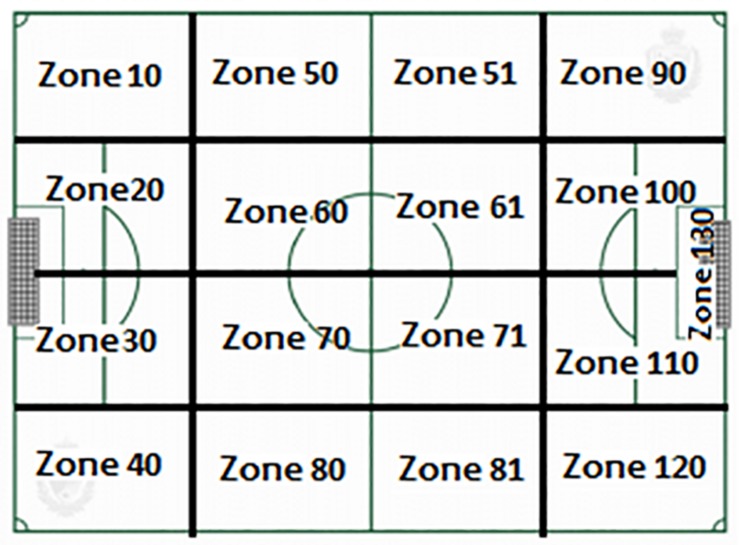
Pitch áreas: sectors. Source: Garganta (1997).